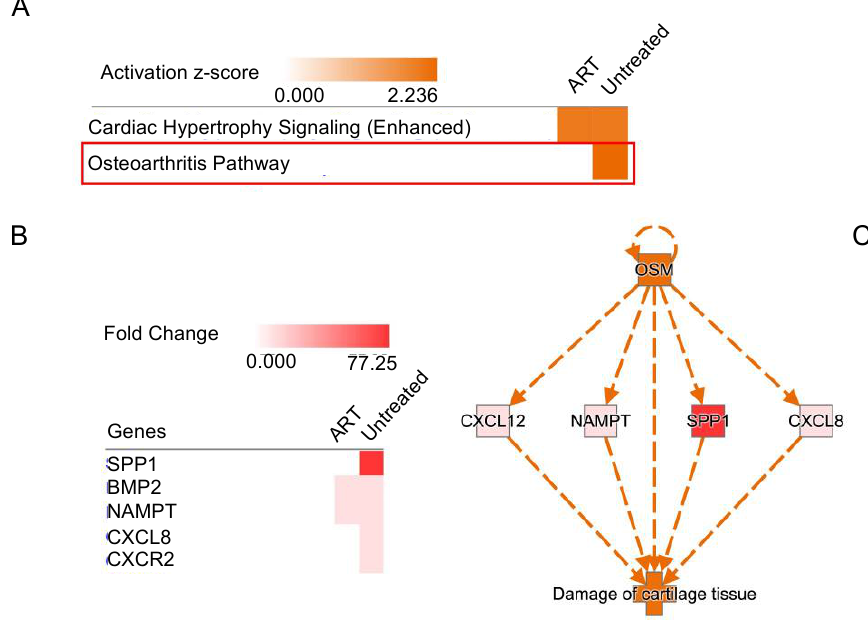
Figure 8. ART vs. Untreated Pathway Analyses. ( A ) Canonical pathways enrichment analysis. The red box highlights the discrepant pathway between groups. ( B ) Expression of genes in the osteoarthri- tis pathway. ( C ) Regulator Effects network in the untreated group. It illustrates the relationships be- tween the upstream regulator (OSM) and downstream function and diseases (damage of cartilage tis- sue). The measured and predicted activation is represented by the red and orange colors, respectively.